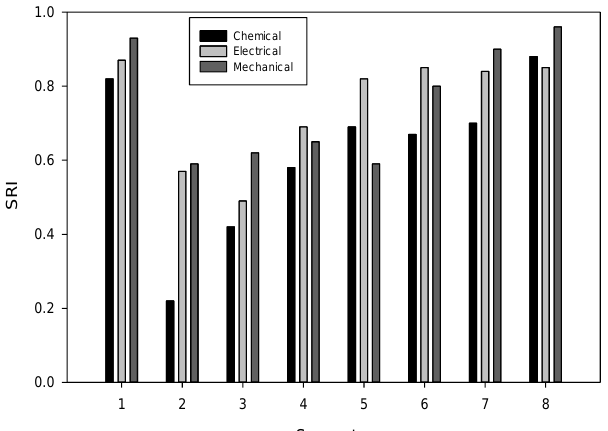
Figure 3. Relaxation index for each semester in the study plan for the Chemical, Electrical, & Mechanical Engineering at the Petroleum Institute (PI)